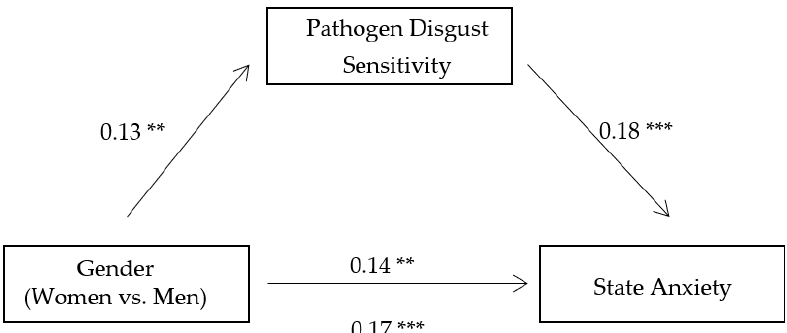
Figure 1. The mediating role of pathogen disgust sensitivity between gender and state anxiety. Note: Significance of the standardized regression coefficients is indicated (** p < 0.01 and *** p <